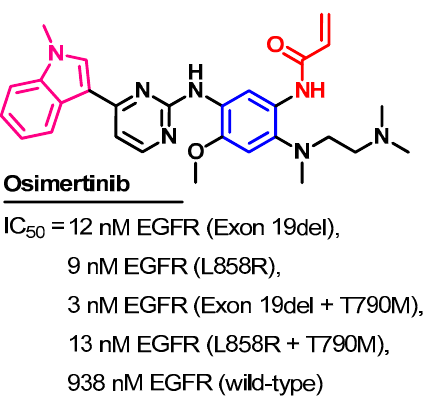
Figure 53 . Binding modes of osimertinib (shown as sticks) into the wild-type EGFR kinase (pdb: 4ZAU): ( A ) 3D binding mode, receptor shown as hydrogen bond surface; ( B ) 2D binding mode showing different types of binding interactions; the figure was generated using Discovery Studio Visualizer (V16.1.0.15350). The binding mode and interactions of osimertinib into the active site of the EGFR 696-1022 T790M (pdb: 6JX0) are visualized in Figure 54. Osimertinib shows two conven- tional hydrogen bonds into the active site of EGFR 696-1022 T790M [136].